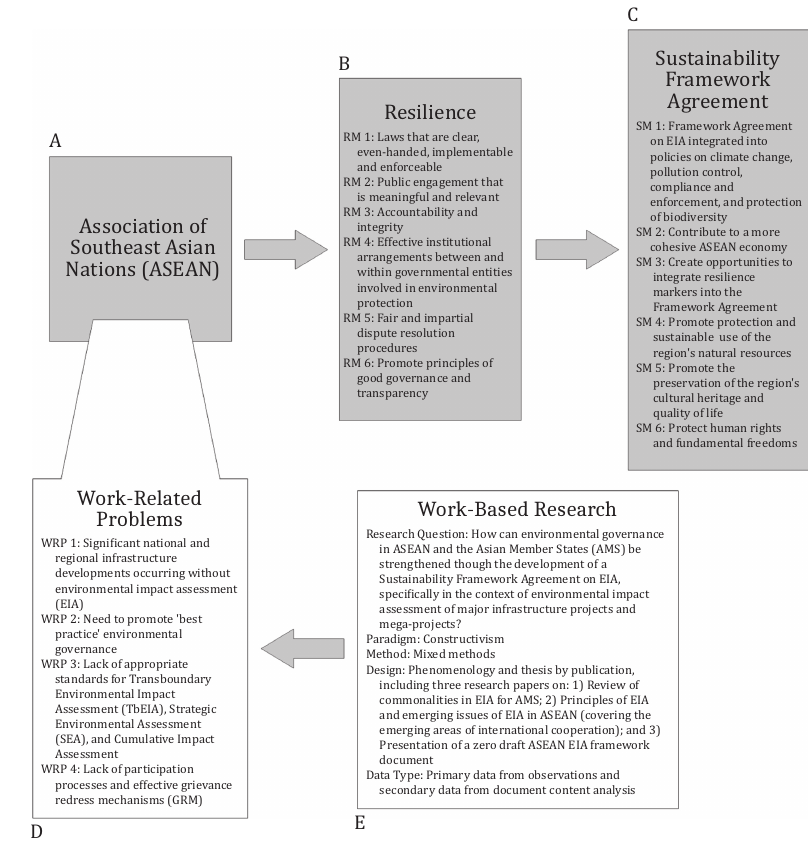
Figure 5. Planning model for sustainable futures Study No.